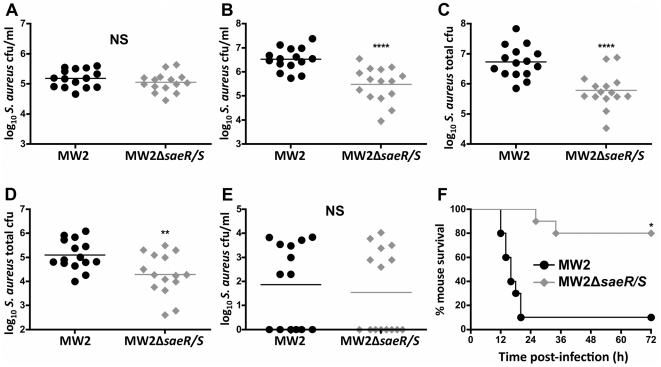
SaeR/S promotes bacterial persistence and host mortality in a mouse model of S. aureus peritonitis.Mice were inoculated i.p. with MW2 or MW2ΔsaeR/S (5×107 cfu) for (A) 4 hours and (B–E) 10 hours. (A) S. aureus burden in the peritoneal exudate, NS. For data in (A), results are from 3 biological replicates of 5 mice/group (n = 15). (B) S. aureus burden in peritoneal exudate, ****P<0.0001. (C) S. aureus burden in the kidneys, ****P<0.0001. (D) S. aureus burden in the heart, **P<0.01. E, S. aureus burden in the blood, NS. For data in (B–E), results are from 2 biological replicates of 7 and 8 mice/group (n = 15). All tissues compared were individually analyzed by t test. (F) Survival curve for mice inoculated (i.p.) with 5×107 cfu of MW2 or MW2ΔsaeR/S, *P<0.001 as determined by logrank test (n = 10/group). Mice receiving PBS had no S. aureus cfu (data not shown). NS = not significant.